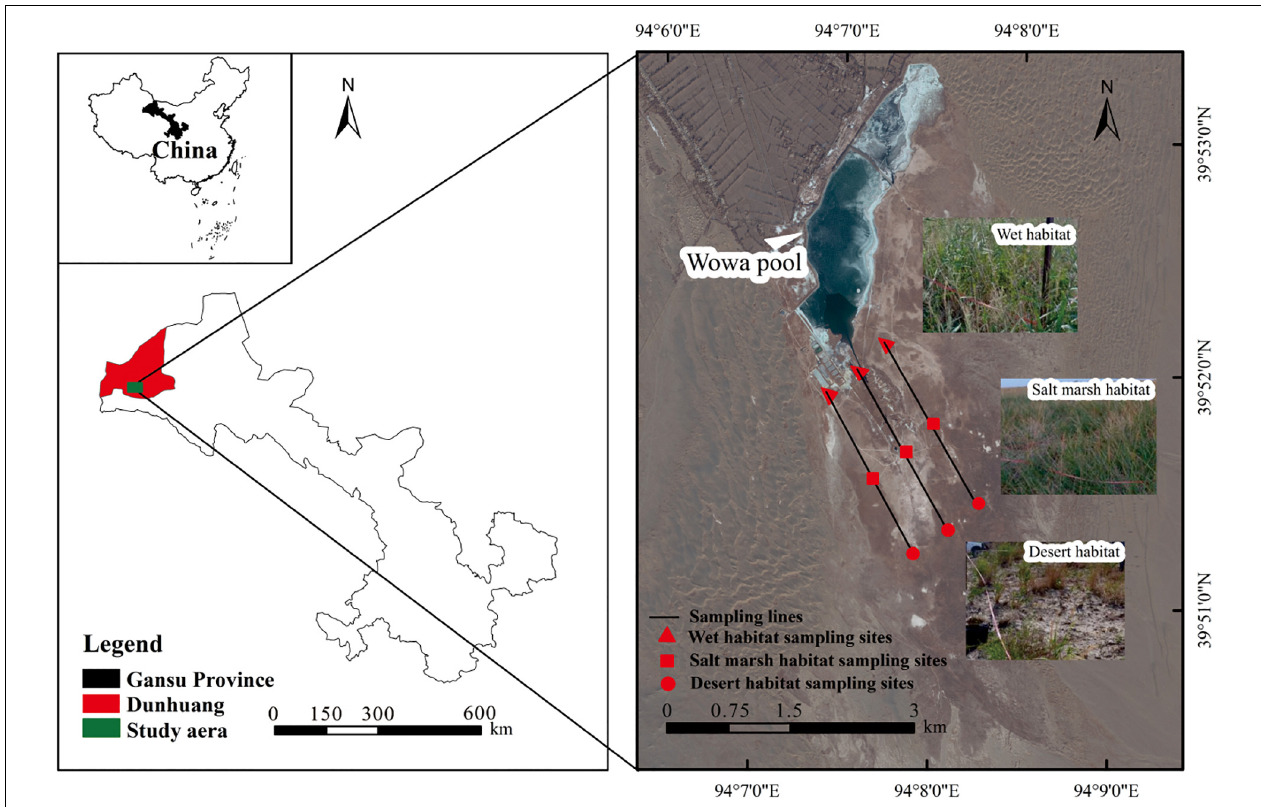
FIGURE 1 | Study area and sampling point